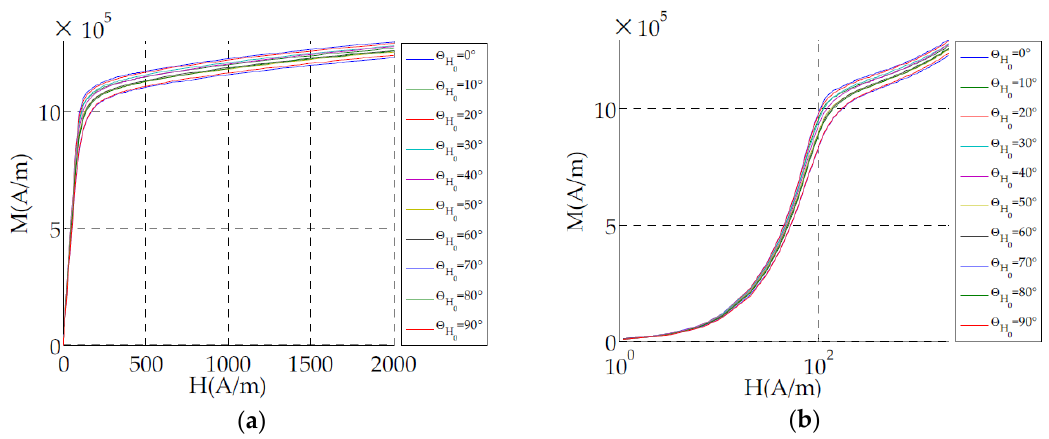
Figure 1. Non-hysteretic (anhysteretic) plotted magnetization curve according to the magnetic field directions: ( a ) linear; ( b ) logarithmic scale.